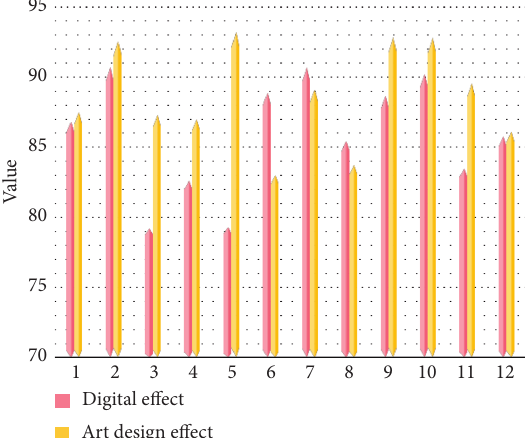
Figure 9: Histogram of experimental parameters of the art design system.